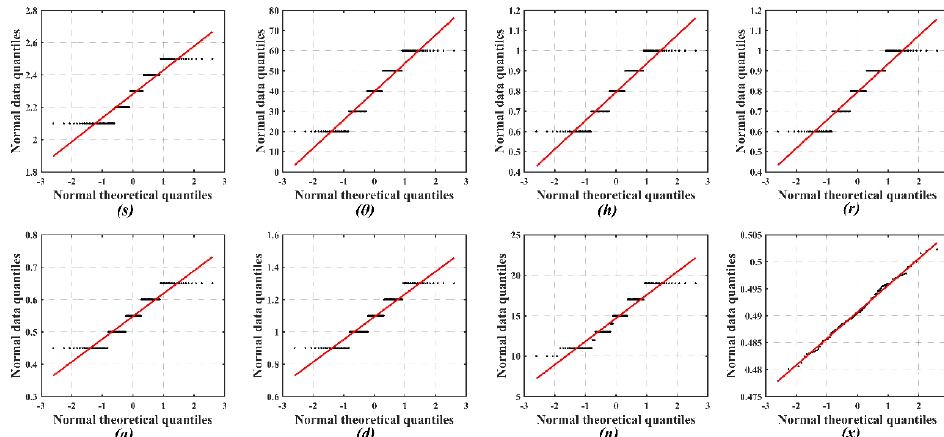
Figure 8. Quantile–quantile plot of the dataset.